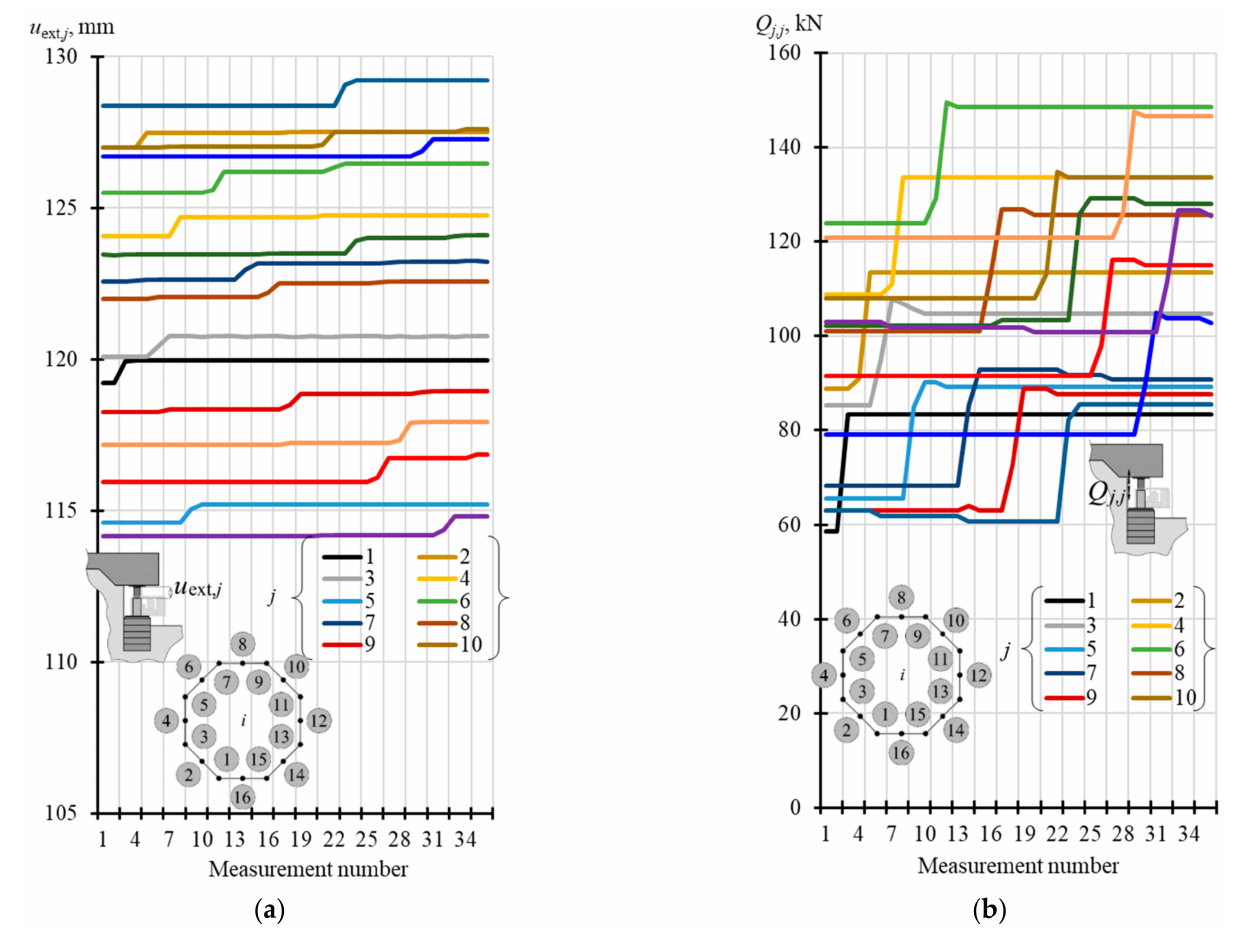
Figure 10. Results from in-situ tests for active supports ( a ) recorded forced piston extensions u ext, j ; ( b ) recorded changes in forces Q j,j in the